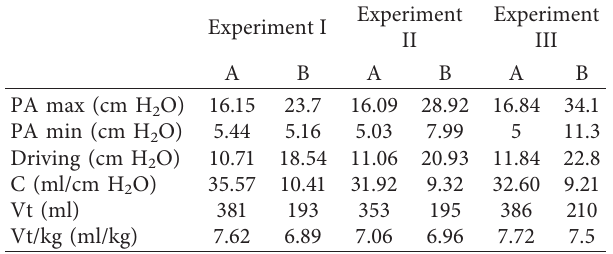
Table 6: Stage 3 in PCV. Experiment I